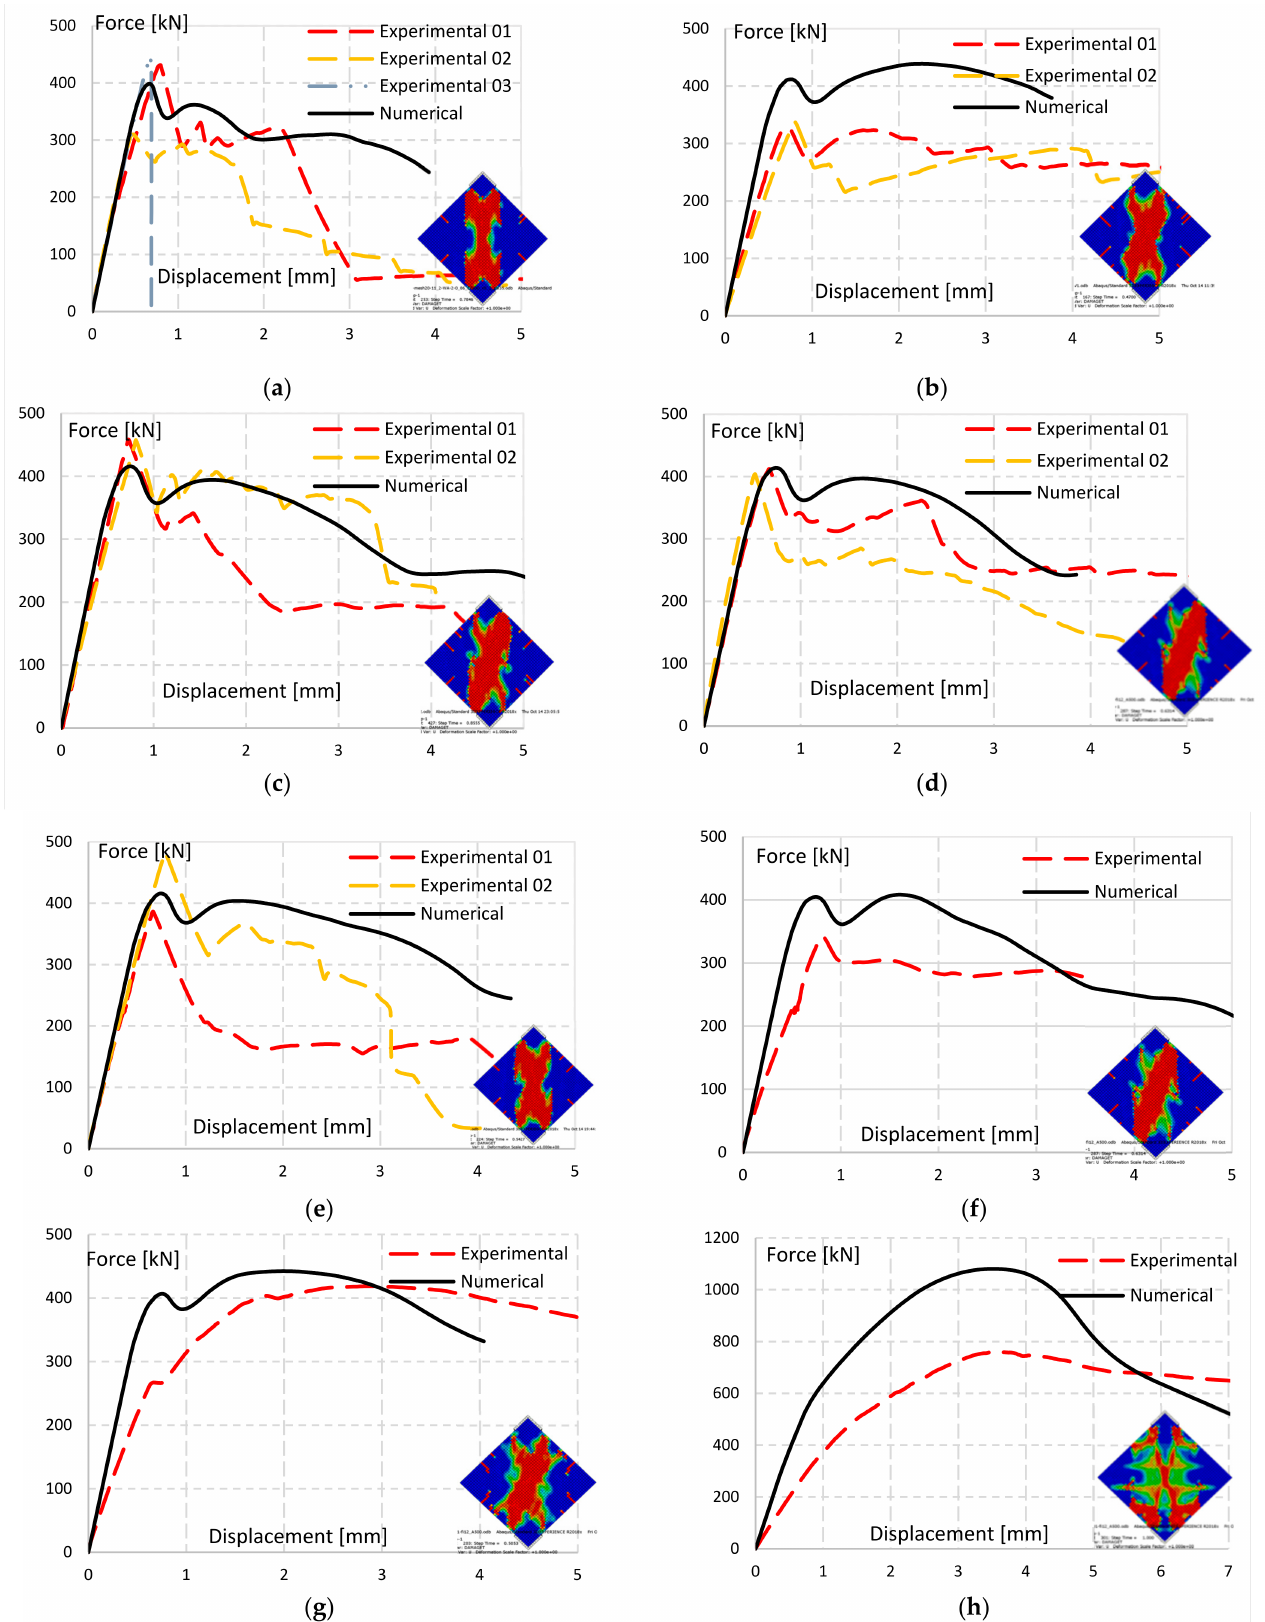
Figure 21. Force-displacement curves of numerical models vs. experimental results. ( a ) UR; ( b ) 2HV1; ( c ) 1H2; ( d ) 2H1; ( e ) 1V1; ( f ) 2H1-SB Φ 12; ( g ) 2HV1-SB Φ 12; ( h ) 2DD1-SB Φ